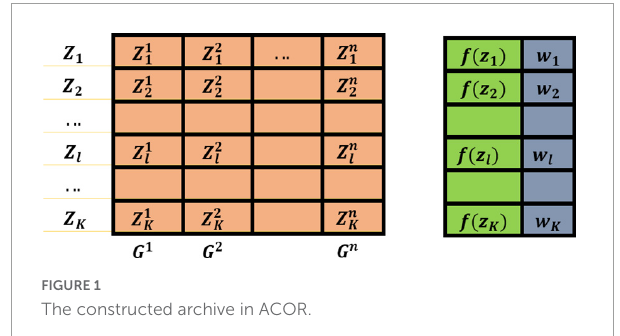
FIGURE1 The constructed archive in